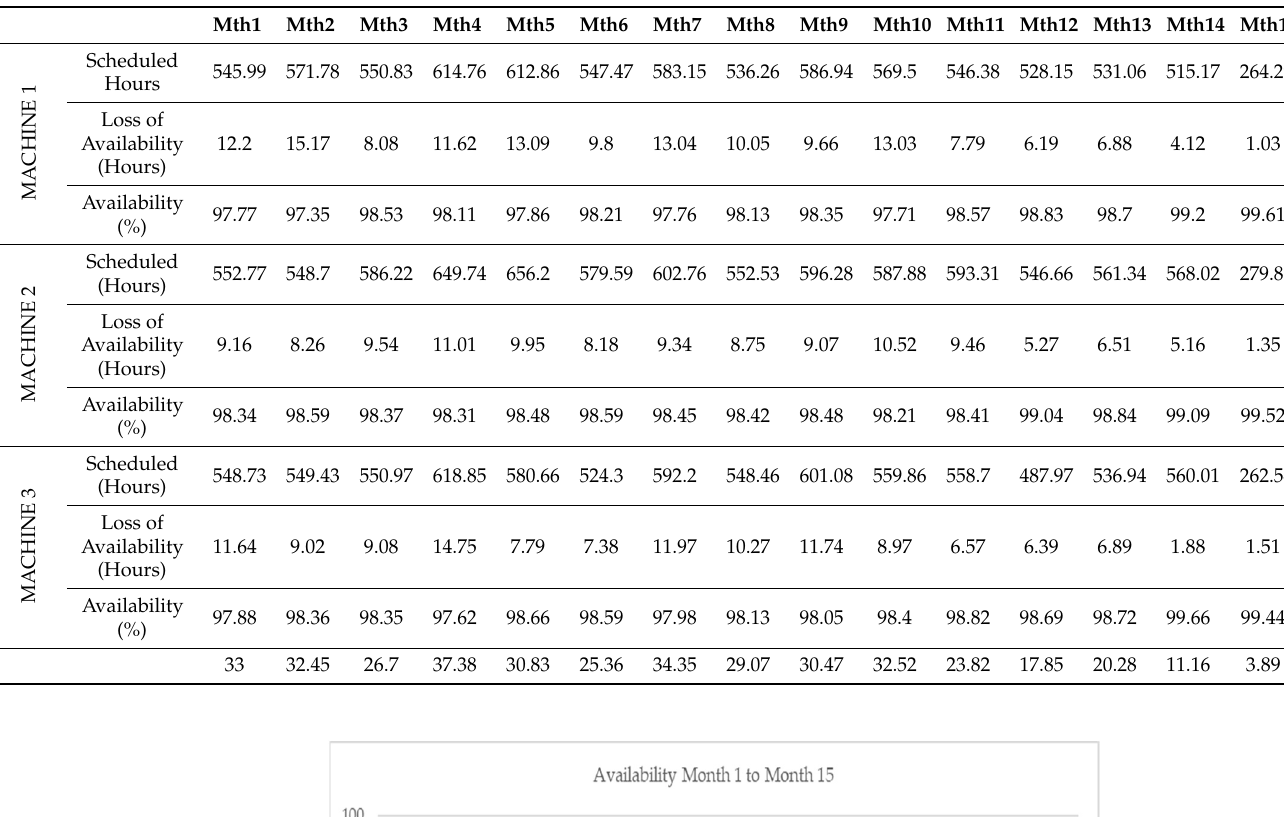
Table 2. Scheduled hours and loss of availability in three machines over fifteen months.